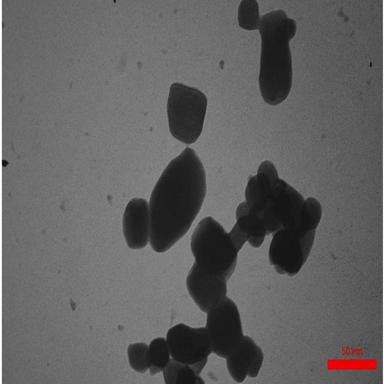
TEM image of the three-component Fe3O4/QSM/Ag composite.